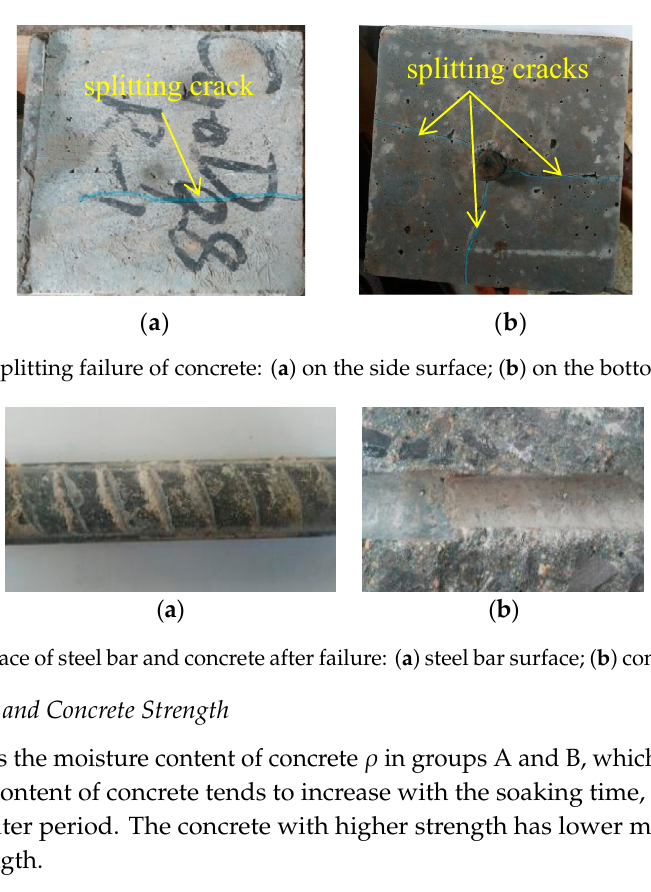
Figure 3. Slip surface of reinforcement and concrete after failure: (a) Steel reinforcement surface; (b) Concrete slip surface.